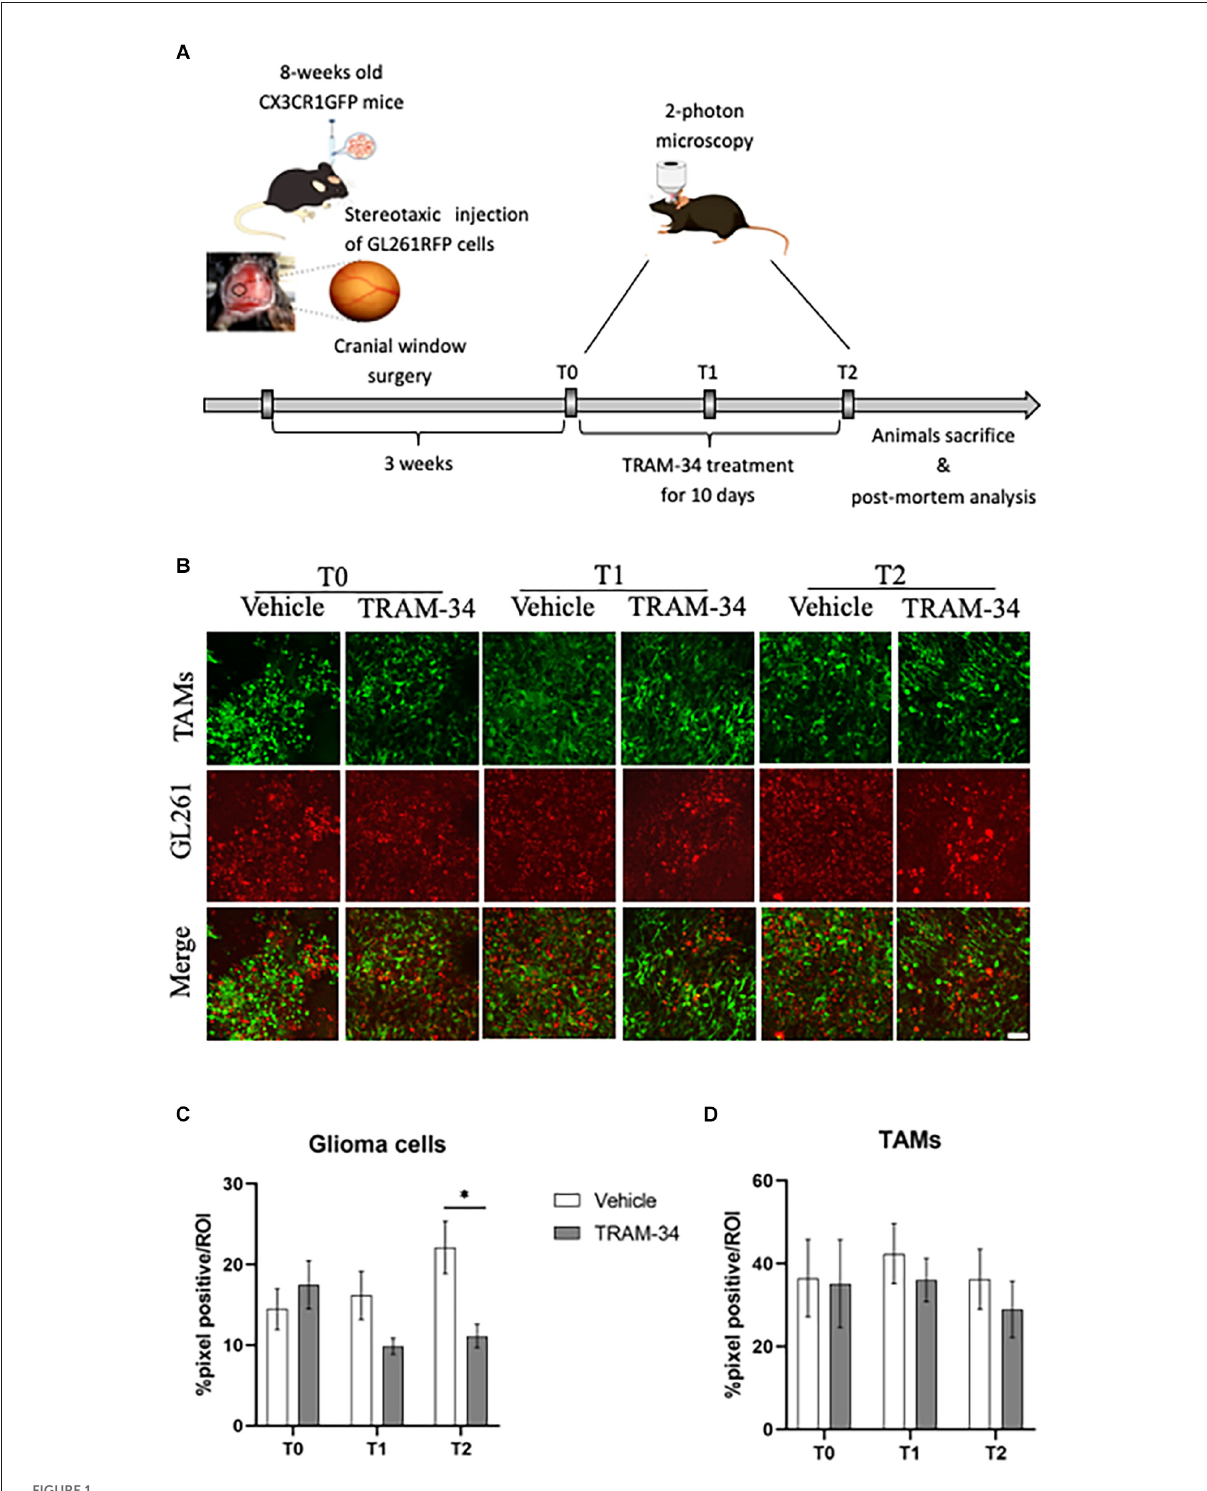
FIGURE1 Experimental procedures and analysis of TAMs-glioma interaction in vivo . (A) Experimental design of drug treatment and two-photon acquisition. (B) Representative two-photon images of TAMs-glioma (GL261 cells) interaction before starting drug treatment (T0), halfway through (T1), and at the end (T2) of i.p. treatment with TRAM-34 (120 mg/Kg) or vehicle (100 µ l of peanut oil). Scale bar 50 µ m. Weka segmentation (ImageJ) quantification of GL261-positive pixel (C) or TAMs-positive pixel (D) within a picture’s ROI at each day of acquisition (T0, T1, T2) in treated and control mice. Vehicle 10 animals, TRAM-34 nine animals, one picture per animal. TAMs, Tumor associated macrophages. Two-way ANOVA ± S.E. ∗ p <